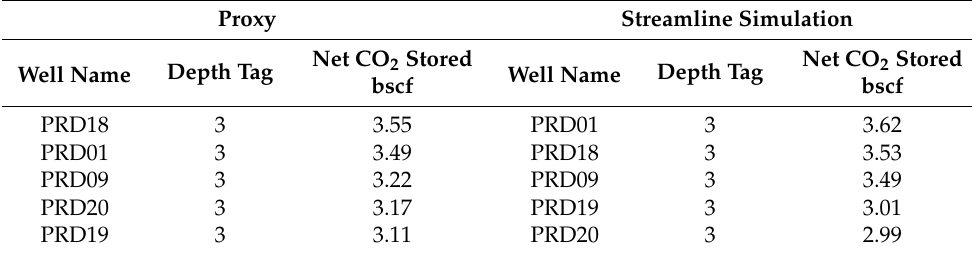
Table 12. Proxy performance compared with numerical simulation on the blind test (CO 2